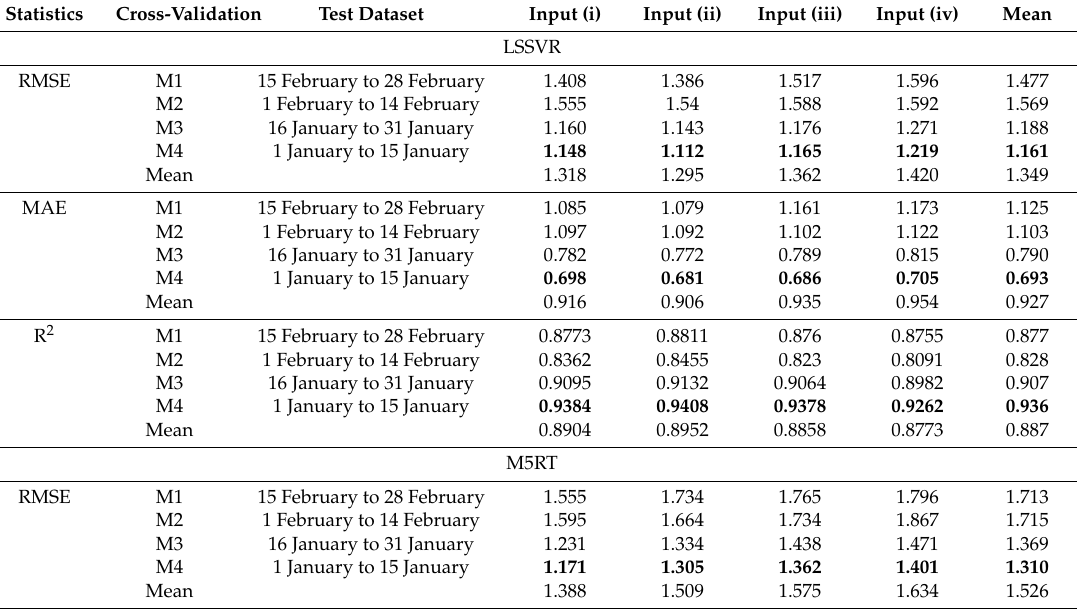
Table 8. LSSVR and M5RT results in wind power